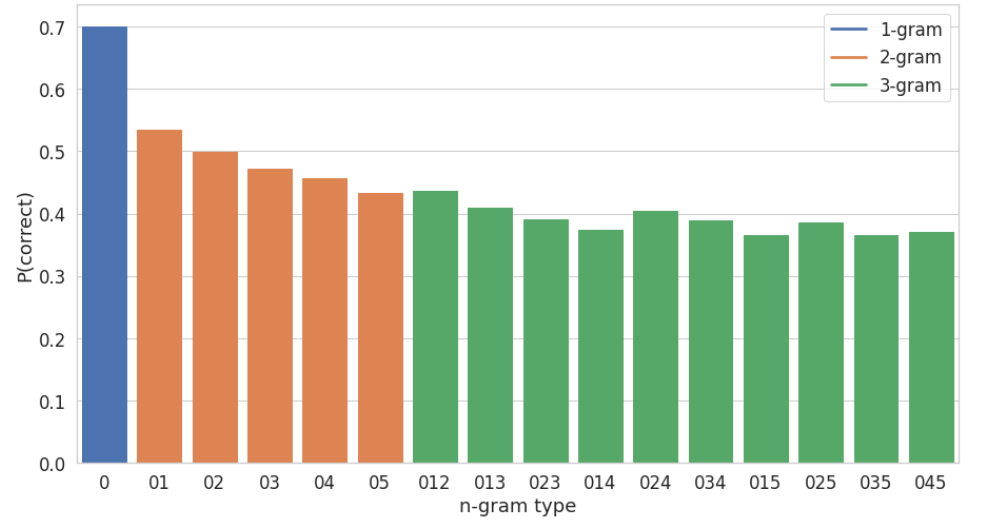
Figure 3. Probability of correctness for all 16 generalized n-gram types, as estimated on the training queries. This probability of correctness is used as a measure of a fingerprint’s utility. The n-gram type is indicated as a string where, for example, “025” corresponds to the 3-gram ( x i , x i + 2 , x i + 5 )